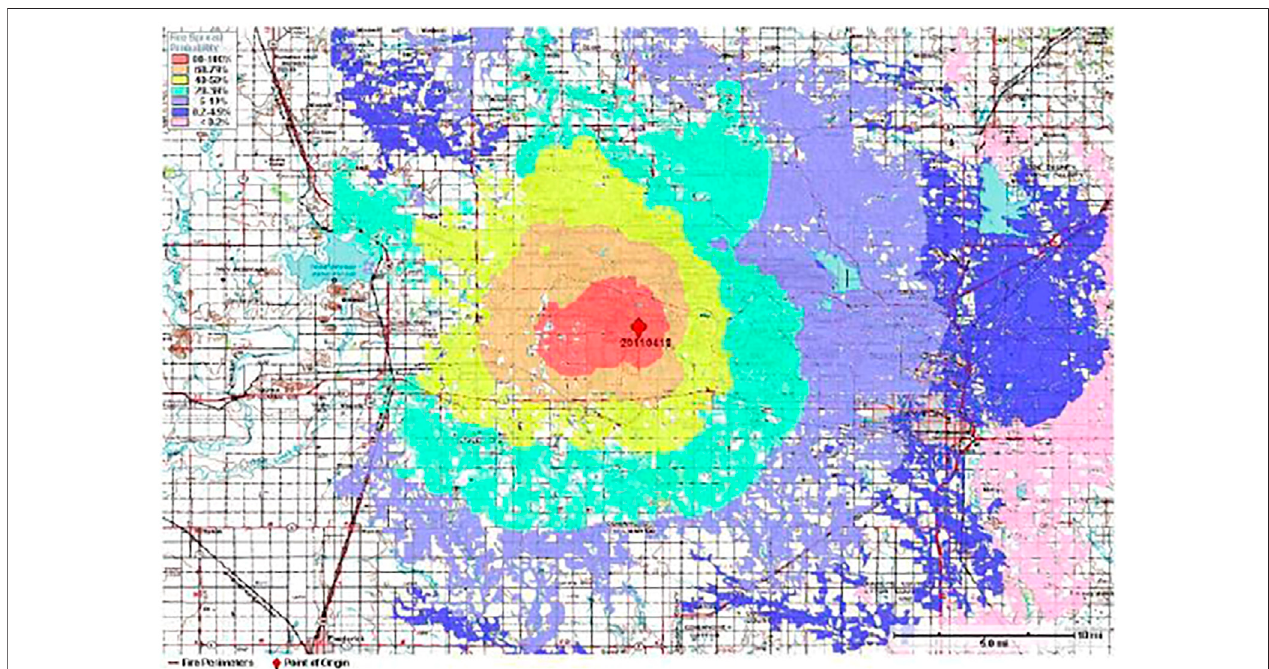
FIGURE 4 | Probabilistic fi re perimeter under no-suppression scenario (Indiahoma Wye Fire, 2011) (source: FSPro output by Erin Noonan-Wright, U.S. Forest Service, Rocky Mountain Research Station, 2016).